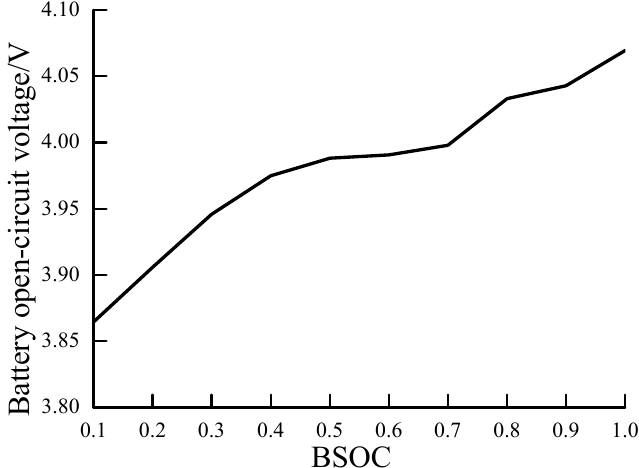
Figure 5. Relationship between open-circuit voltage and battery state of charge (BSOC) [19].